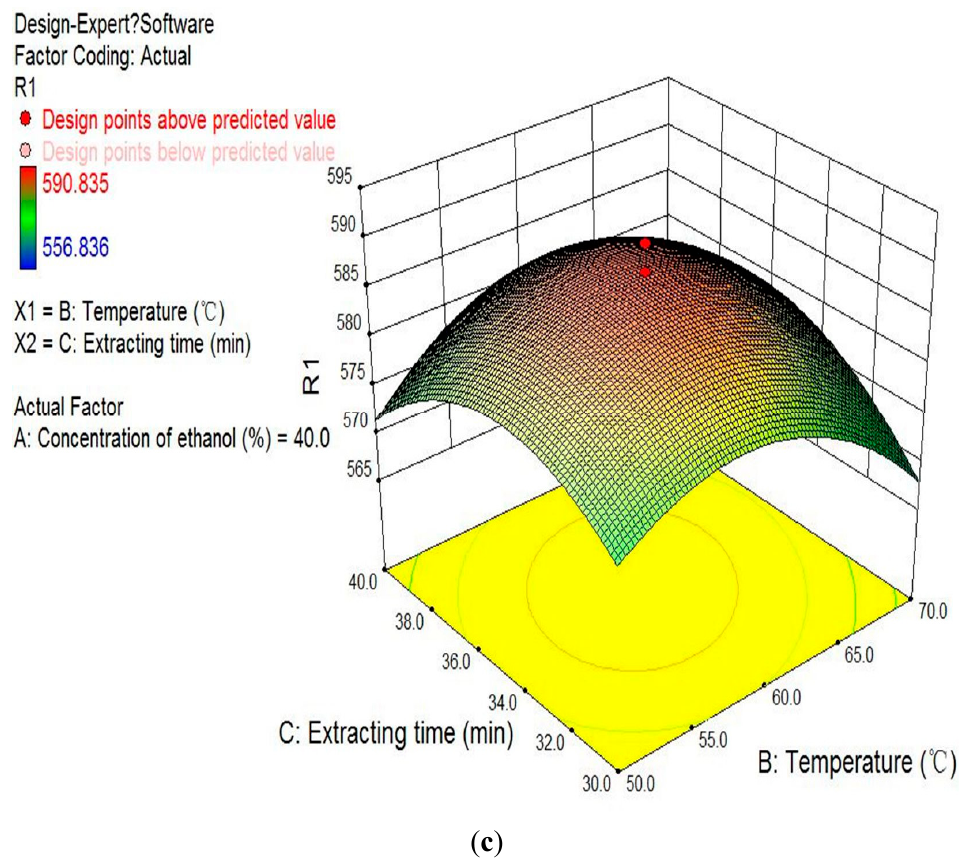
Figure 2. Response surfaces for the combined effects of concentration of ethanol and extracting temperature ( a ); concentration of ethanol and extracting time ( b ); and extracting temperature and extracting time ( c ).